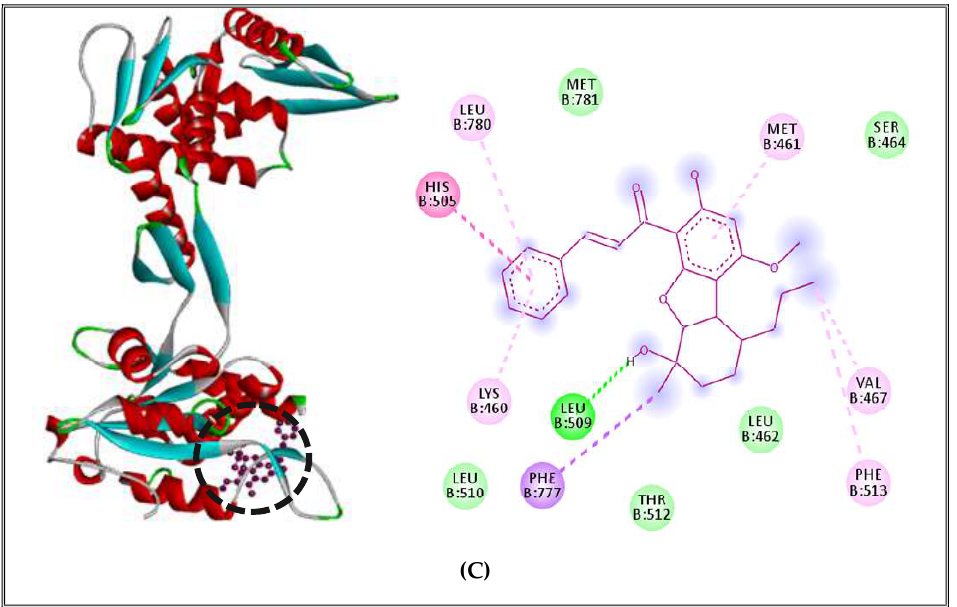
Figure 9. Borneol complexed with DNA polymerase enzyme ( A ), RNA polymerase ( B ), topoiso- merase II ( C ) of S. enterica Typhimurium.